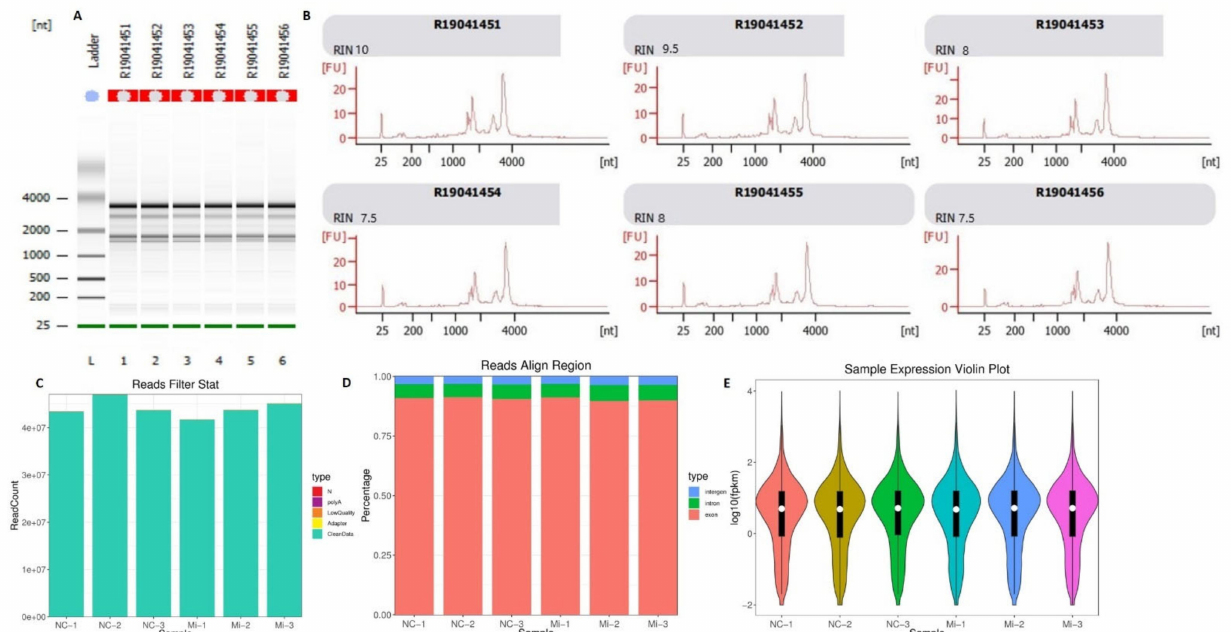
Figure 2. Quality and integrity of the RNA samples and data analysis. ( A ) RNA quality and integrity of adipocytes transfected with miR-149-5p mimic and mimic NC. ( B ) The reliability of the sequenced data collected from adipocytes transfected with miR-149-5p mimic and mimic NC. ( C ) The filtering of clean reads: the blue color represents the high-quality reads after removal of the adapters and low-quality bases. ( D ) The clean reads were aligned and represented with different colors, which exhibited different types of genomic regions: intergenic region (blue), intronic region (green), and exonic region (red). ( E ) The distribution of FPKM (fragment per kilobase of transcript per million mapped reads) in each sample of the 2 groups (adipocytes transfected with miR-149-5p mimic and mimic NC). The different colors represent different samples processed as mentioned below each